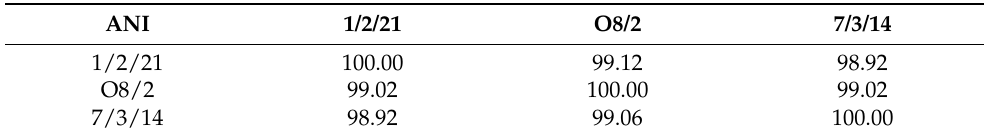
Table 3. Pairwise Average Nucleotide Identity (ANI) analyses for completely sequenced R. solani AG1-IB isolates.